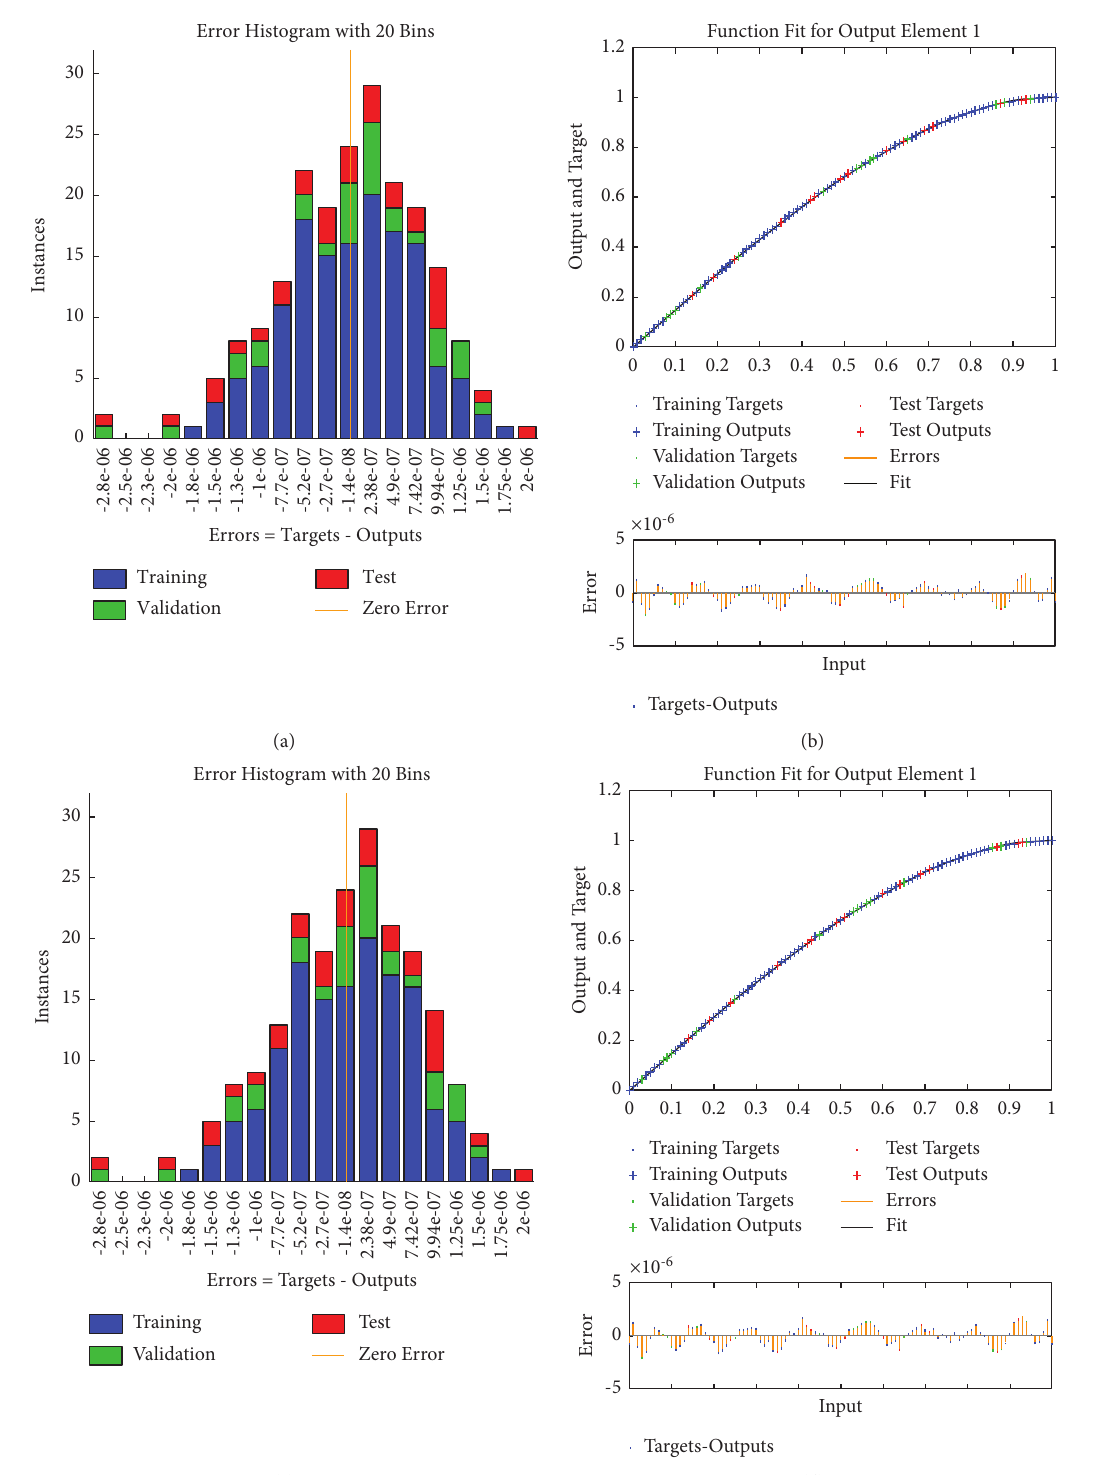
Figure 4: Outcomes of error histograms and fitting graphs of proposed LMA-BANN in two cases of the MPFPCMI